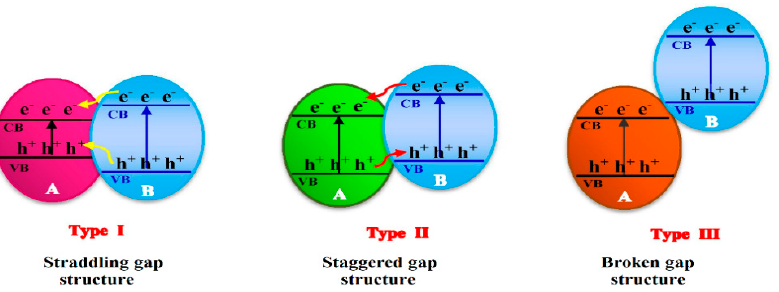
Figure 1. The three types of heterojunction structure of photocatalyst semiconductors